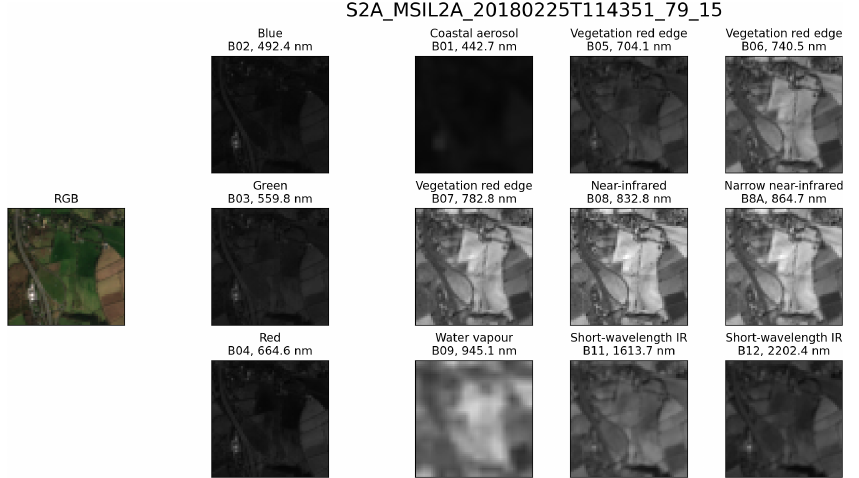
Figure 1. Multispectral image captured by the satellite Sentinel-2 and belonging to the BigEarthNet